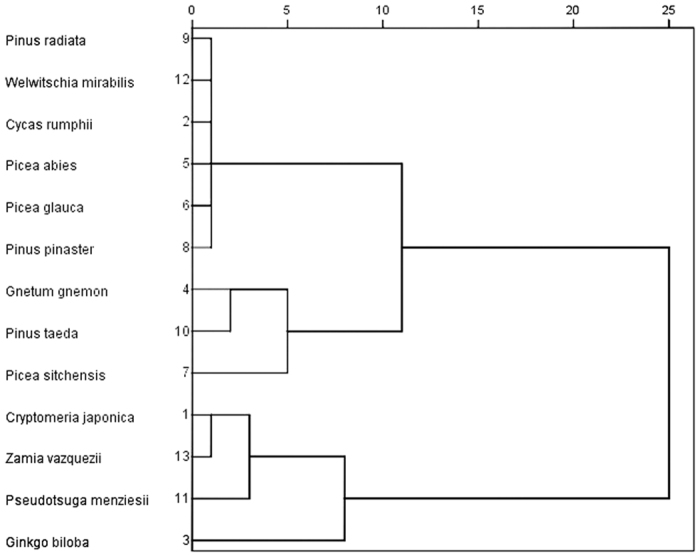
Dendrogram of 13 gymnosperms according to GC3 values.